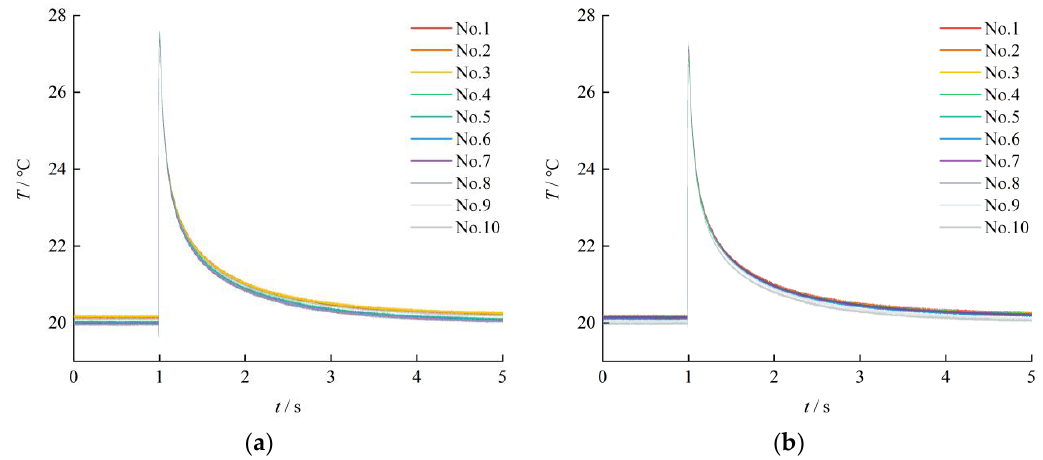
Figure 4. Thermocouple output response curve under single pulse laser excitation: ( a ) Laser A as the excitation source; ( b ) Laser B as the excitation source. Table 1. Thermocouple time constants under single pulse laser excitation.